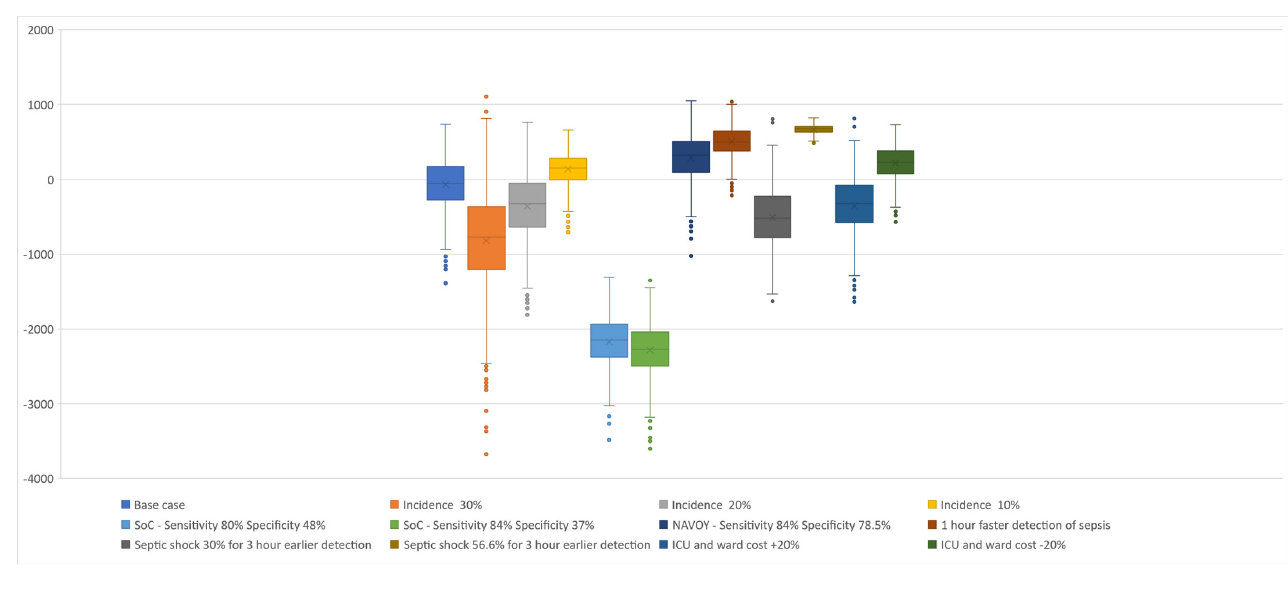
Figure 2. Stochastic Analysis of Cost Impact and